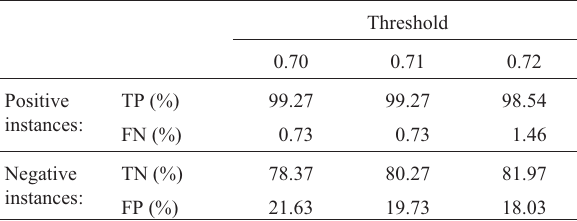
Table 7 - Performance evaluation for model 2.